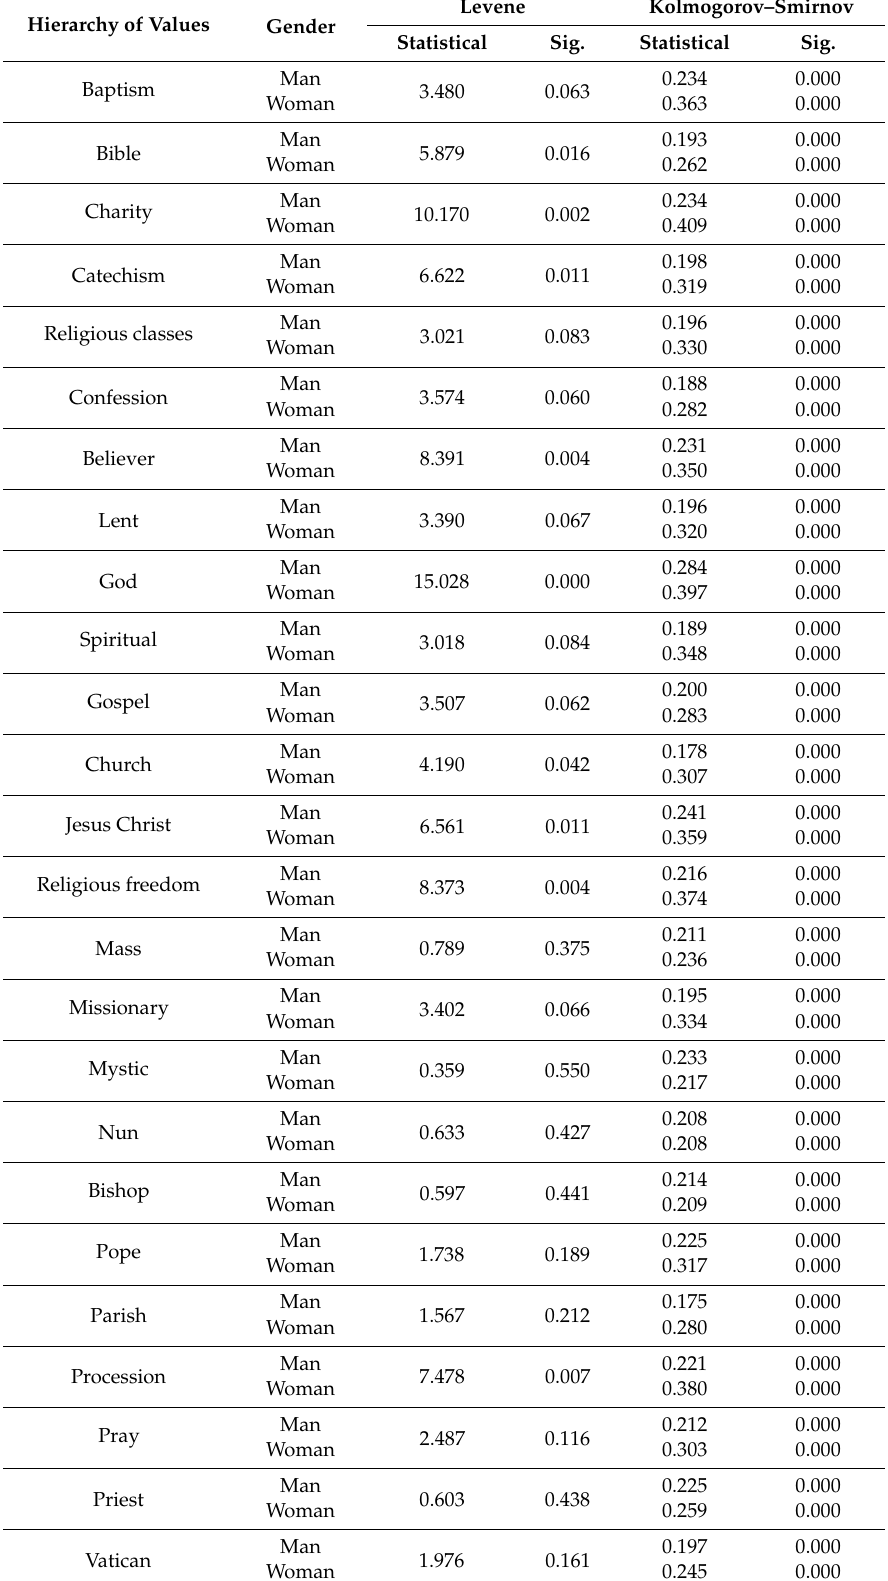
Table A3. Results of the parametric assumptions for the gender variable in Salesian students. Hierarchy of